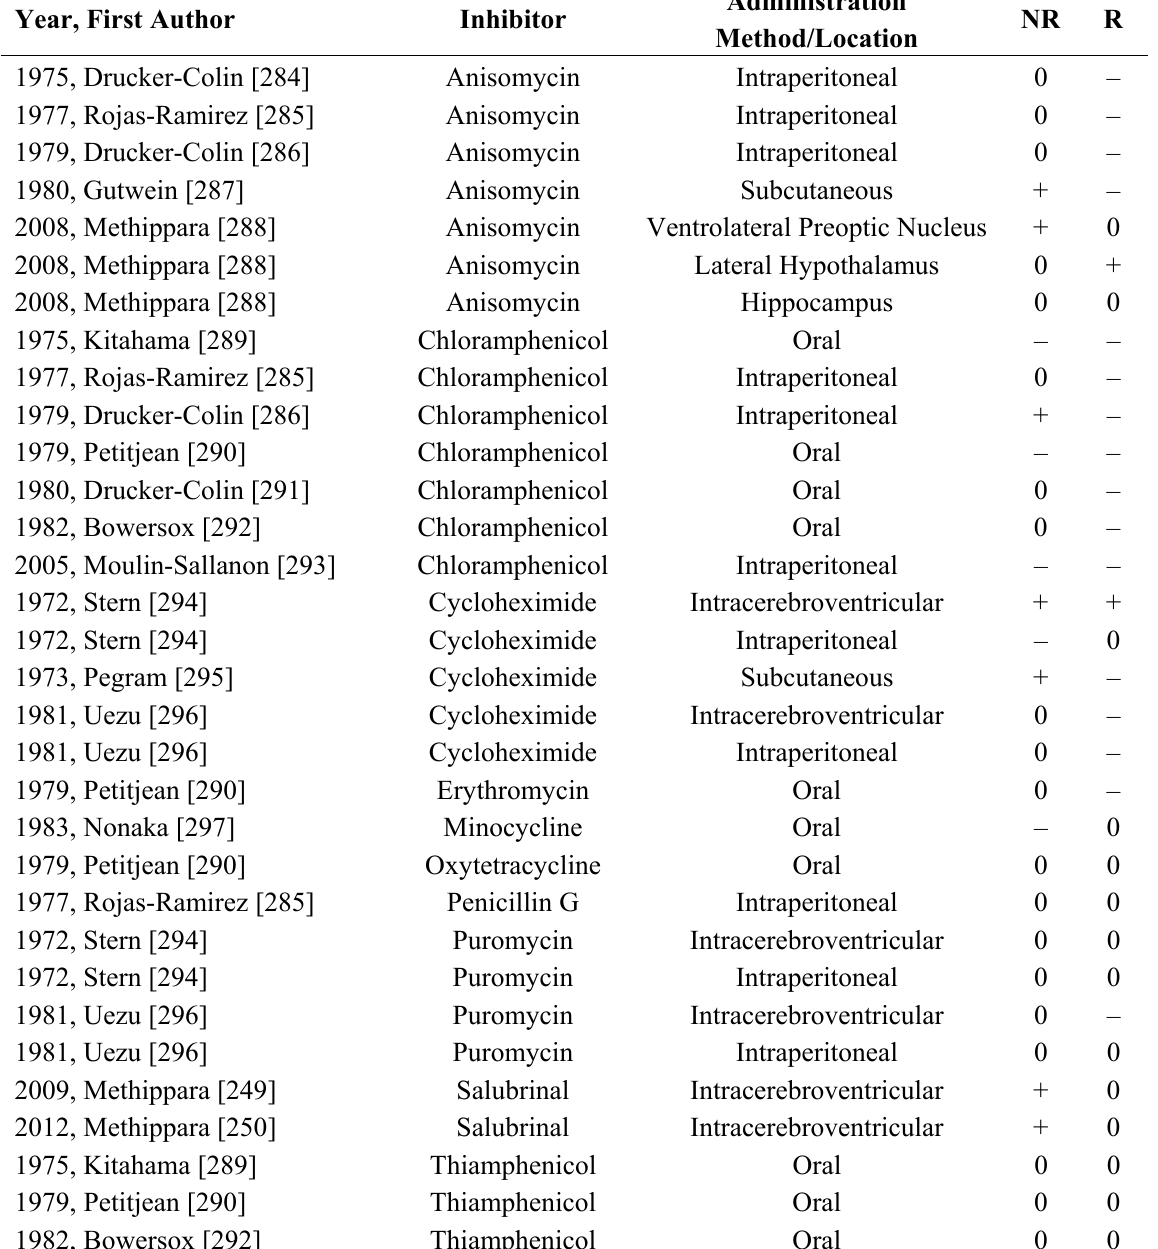
Table 1. Summary of the literature on the effect of protein synthesis inhibitors on